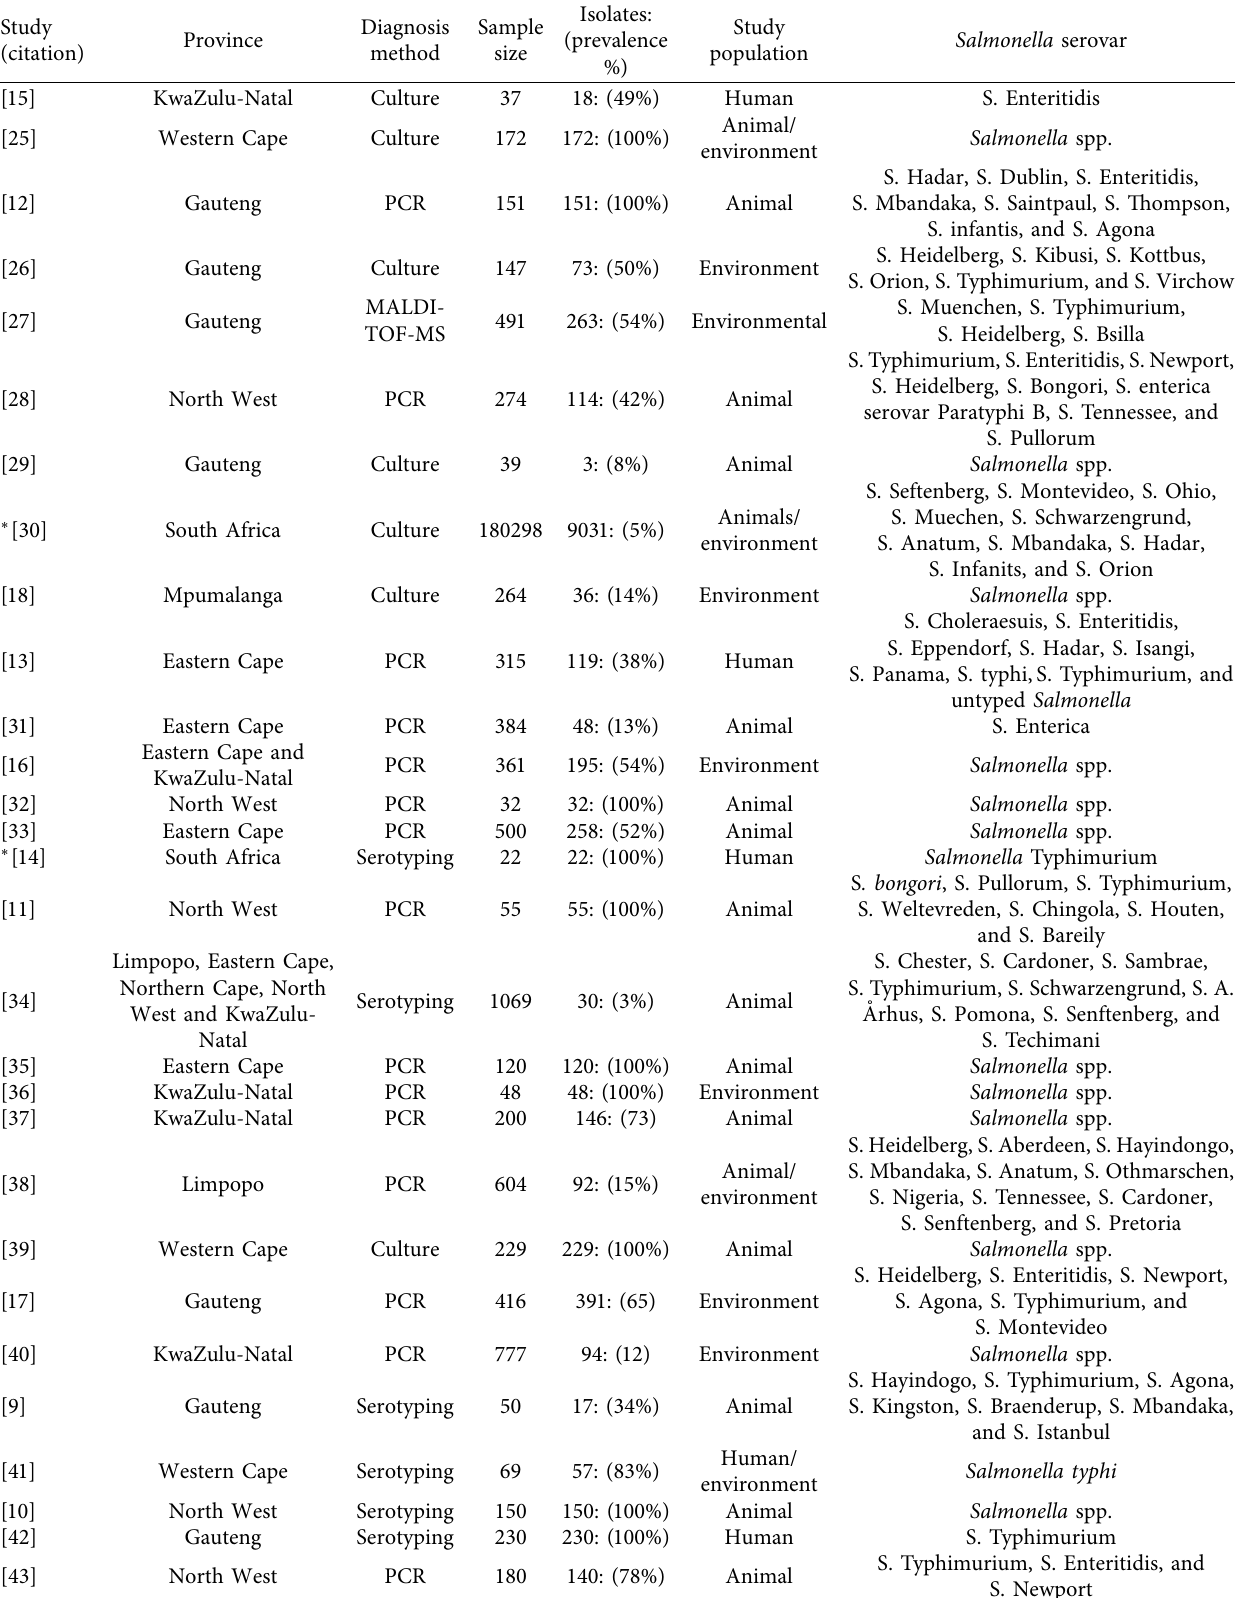
Table 2: Overview of the numbers of research article on Salmonella serovars that were included in this systematic review and meta-analysis. Study